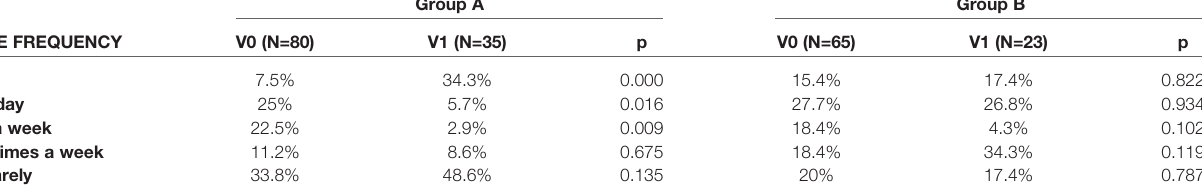
( Table 4 ). Moreover, comparison analysis between the groups documented a signi fi cantly more frequent consumption of sugary drinks and snacks in group B compared to group A at V1 ( Table 5 ). Hours spent in physical activity (OR=2.27, p=0.038) and belonging to group A (OR=0.16, p=0.028) were the only